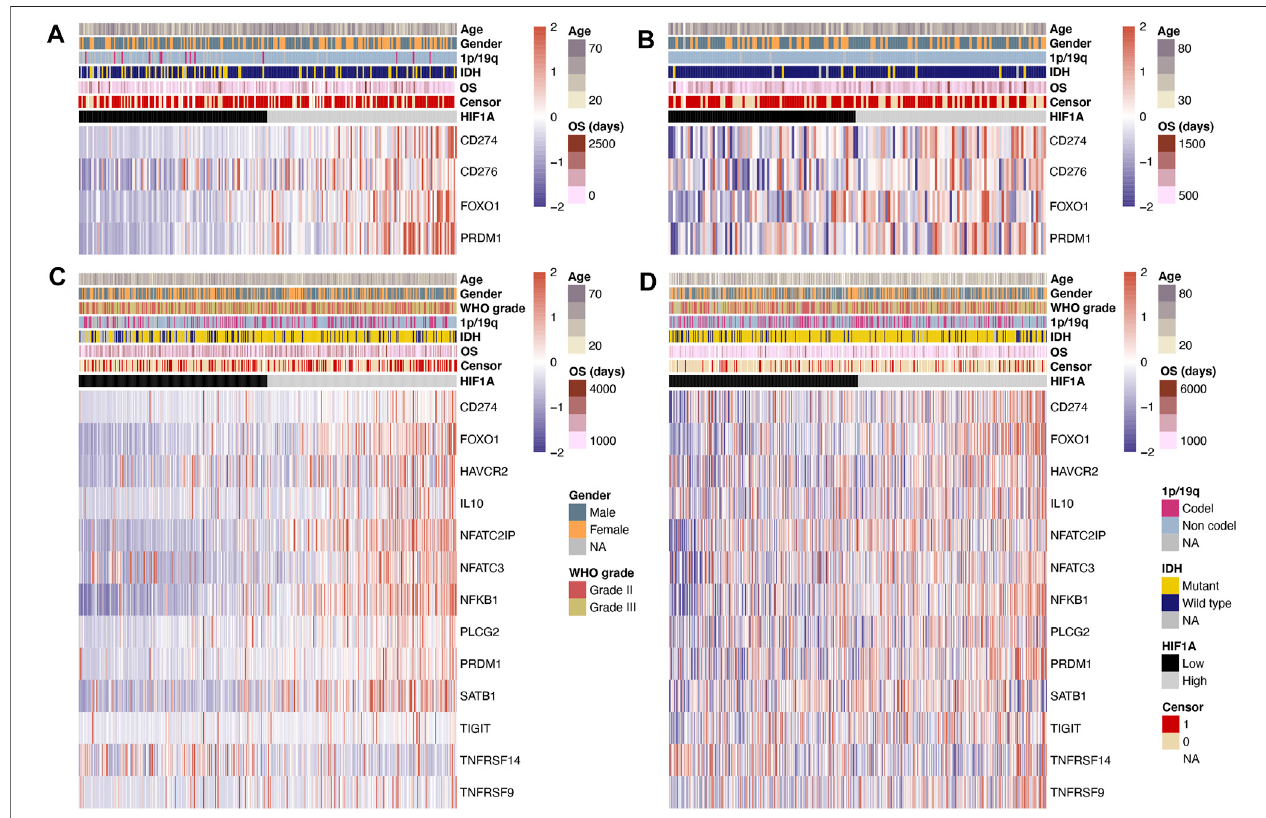
FIGURE 1 | Heatmap ofT-cell exhaustion-related genes under high- and low-HIF1A-expression levels: (A) Data of GBM from the CGGA dataset, (B) data ofGBM from the TCGA dataset, (C) data of lower-grade glioma from the CGGA dataset, and (D) data of lower-grade glioma from the TCGA dataset.